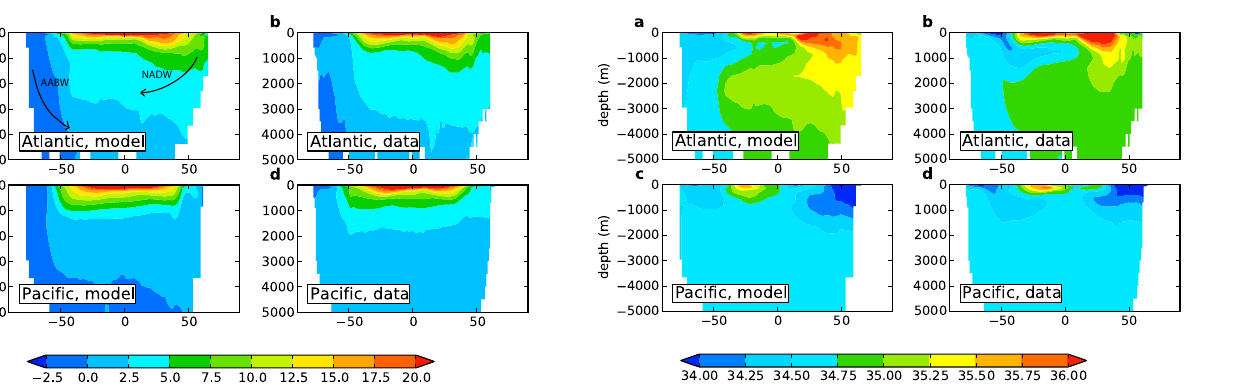
Figure 7. Zonal average of the salinity distribution (psu) in the ocean. Data from the World Ocean Atlas 2009 (Antonov et al., 2010).